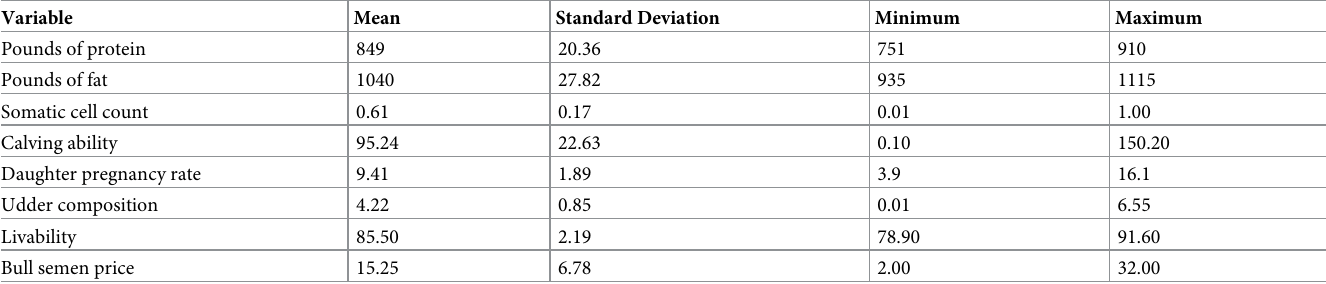
Table 1. Bull data summary statistics from the list of active AI Holstein dairy bulls available in the United States as of October 27, 2017. Variable Mean Pounds of fat Somatic cell